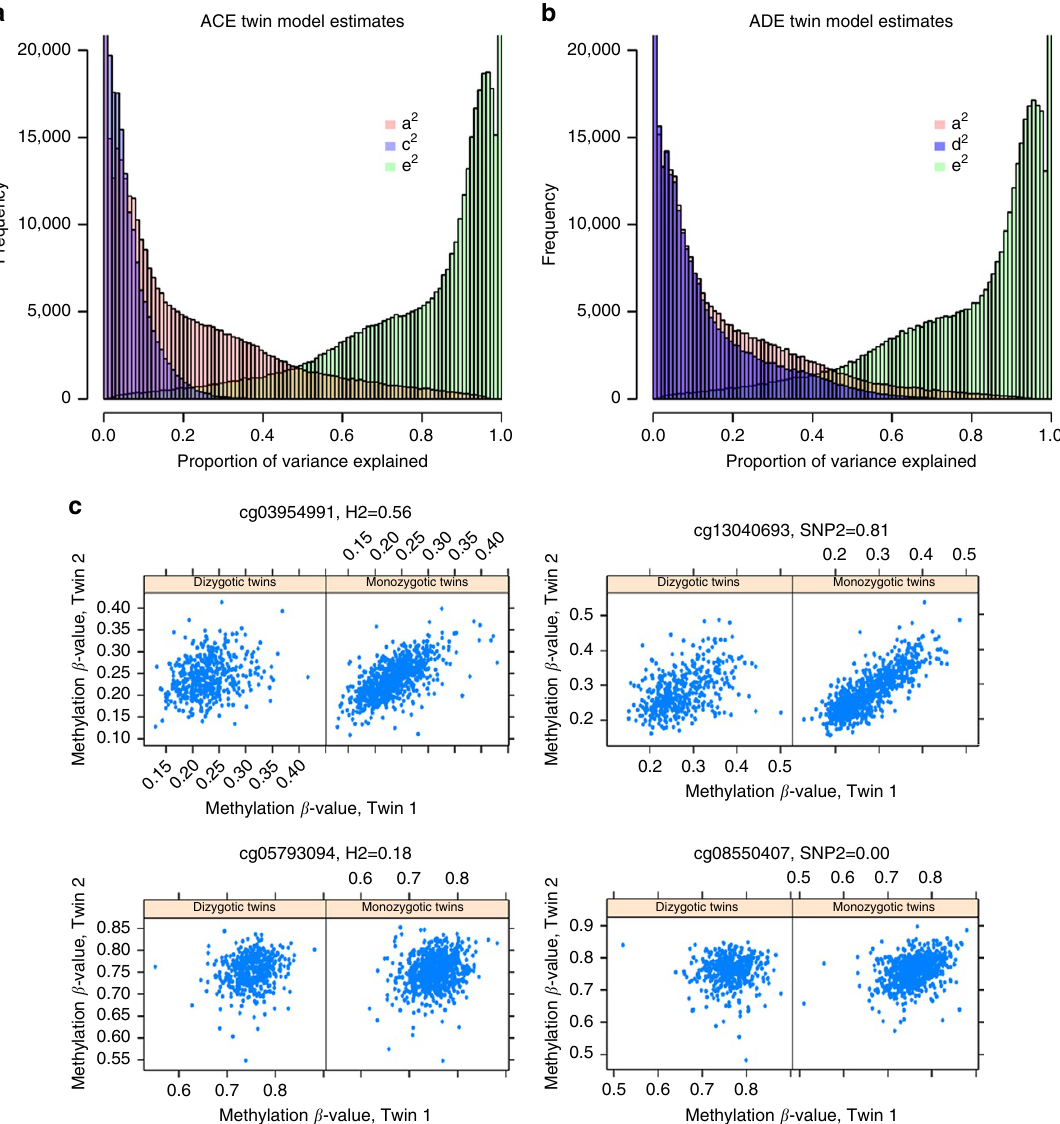
Figure 1 | Genetic and environmental influences on genome-wide DNA methylation levels. Estimates from classical twin modelling in 769 MZ and 424 DZ twin pairs. ( a ) Histograms of genome-wide ACE model estimates: variance explained by additive genetic effects ( a 2 , red), common environmental effects ( c 2 , purple) and unique environmental effects ( e 2 , green). ( b ) Histograms of genome-wide ADE model estimates: variance explained by additive genetic effects ( a 2 , red), non-additive genetic effects ( d 2 , dark purple) and unique environmental effects ( e 2 , green). Y axes are truncated. ( c ) Scatterplots of DNA methylation levels in MZ and DZ twin pairs at four exemplary CpG sites. The DNA methylation level in twin 2 ( y axis) is plotted against the DNA methylation level in twin 1 ( x axis) for all MZ twin pairs and all DZ twin pairs. For illustrative purposes, methylation b -values (which represent methylation proportion) obtained after normalization are plotted in this figure, whereas all analyses were performed on normalized methylation M values, corrected for a number of covariates (see Methods section). Four examples of CpG sites were selected from the most variable CpG sites (s.d. 4 0.03) with high heritability ( h 2 ¼ 0.56; upper left), high SNP heritability ( h 2 SNPs ¼ 0.81; upper right), low heritability ( h 2 ¼ 0.18; lower left) and low SNP heritability ( h 2 SNPs ¼ 0.00, lower right). Note that the larger the difference between the correlation in MZ twins and in DZ twins (stronger correlation in MZ twins), the higher the total heritability. The resemblance of MZ and DZ twins is not informative with respect to the amount of variance explained by genome-wide SNPs. Additional examples are plotted in Supplementary Figs